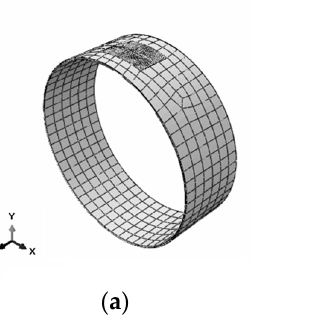
Figure 4. ( a ) Model used for finite element (FE) simulations of all cracks; ( b ) crack opening due to internal pressure loading.